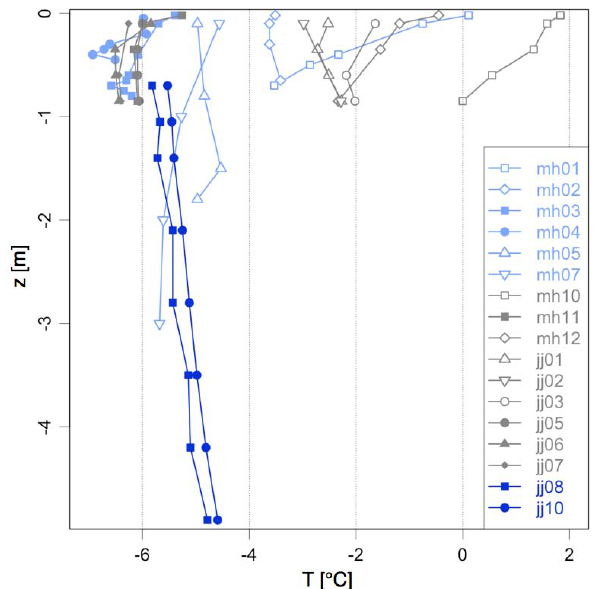
Fig. 8. Mean annual temperature (MAT) profiles for clefts (light blue), rock (grey) and ice (dark blue) with depth z measured perpen- dicular to the surface. Solid symbols are shaded locations (north); hollow symbols are more exposed to solar radiation (south and east). Note that the uppermost MAT of mh01 to mh03 is a rock surface temperature (Table